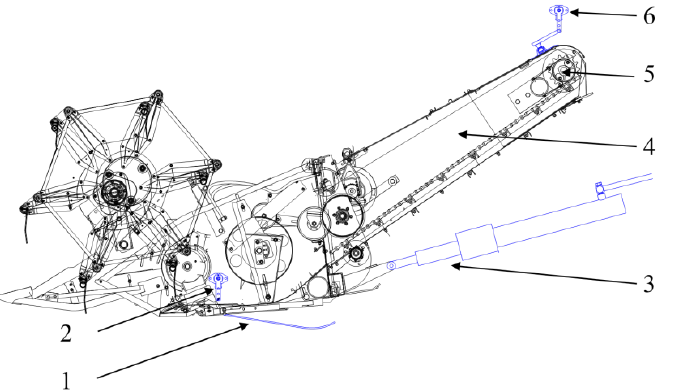
Figure 1. The structure of the ground profile height control system of the header. 1. Profiling roller; 2. Angle sensor; 3. Single-acting hydraulic cylinder; 4. Traditional harvester header structure; 5. Header lift rotation point; 6. Header height feedback